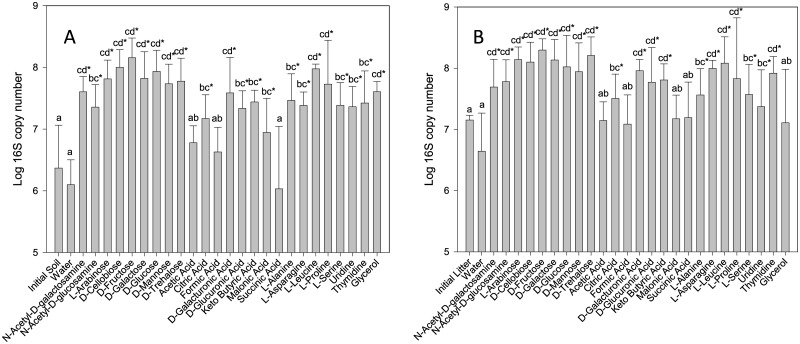
Soil (A) and litter (B) 16S rRNA gene copies in the selected BIOLOG GN2 wells after a 7-d incubation.The same lowercase letters indicate lack of a statistically significant difference (P > 0.05) between C sources. An asterisk represents the occurrence of significant differences (P < 0.05) between each C source and the water control.